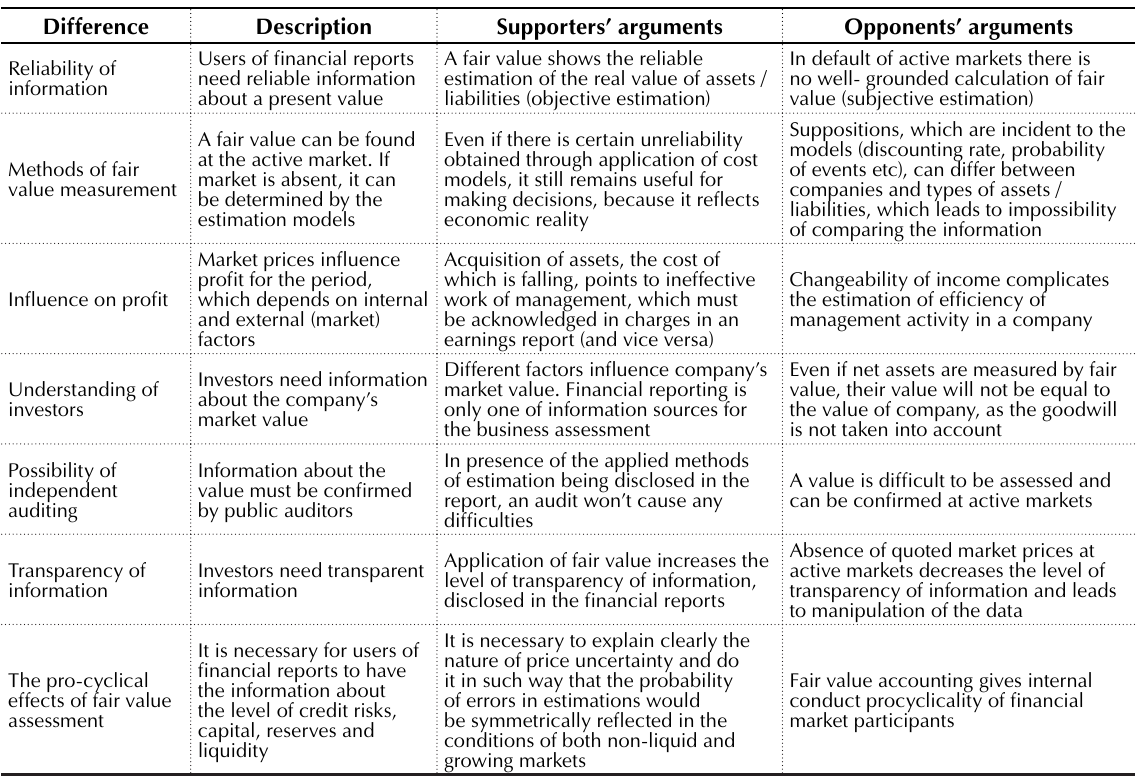
Source: Complemented by the author based on Manko (2009).